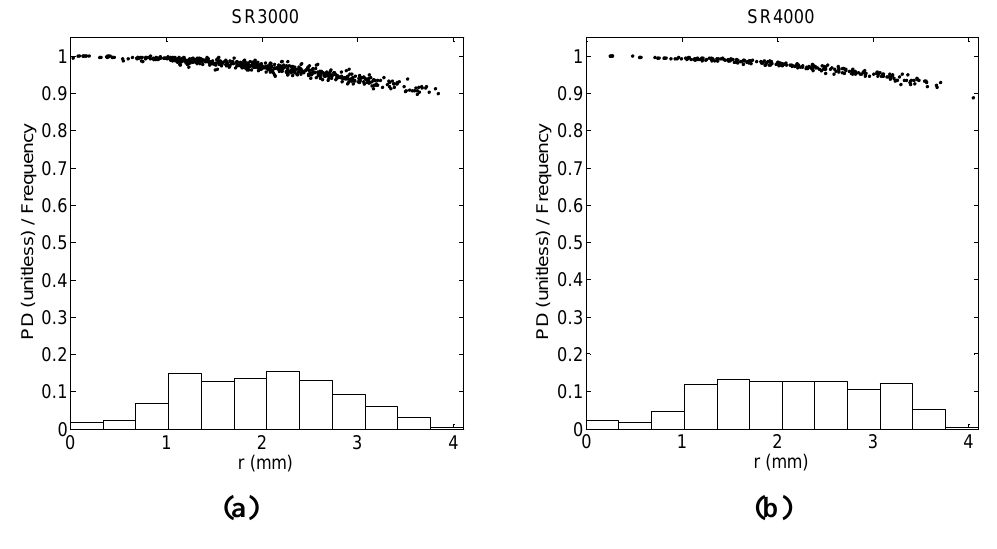
Figure 5. The partial derivative of Equation 12 as a function of radial distance, r, and histograms of image point distribution in the normal images for each dataset. (a) SR3000; (b)